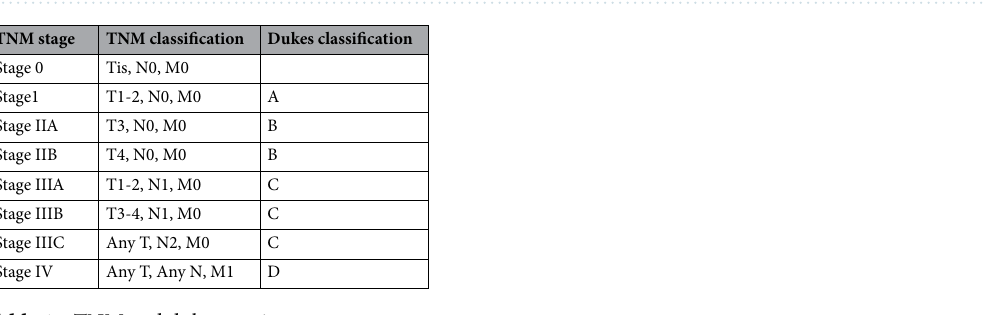
Table 1. TNM and dukes staging.